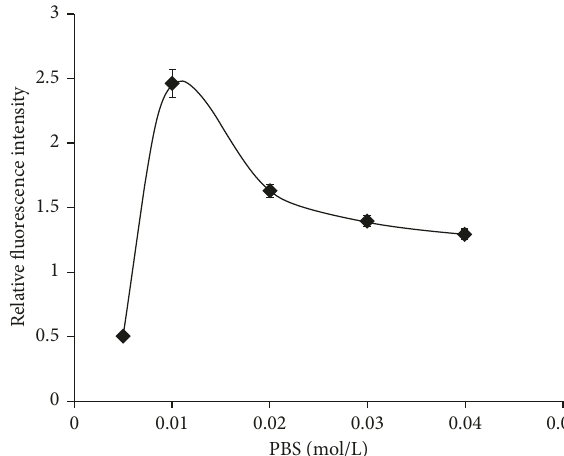
Figure 8: Curve of ionic strength change in MOR competitive fluorescence